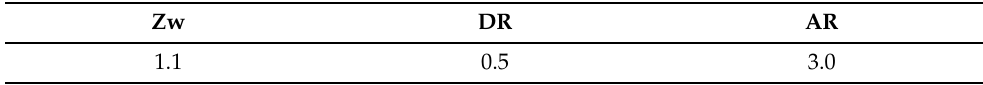
Table 1. Cascade